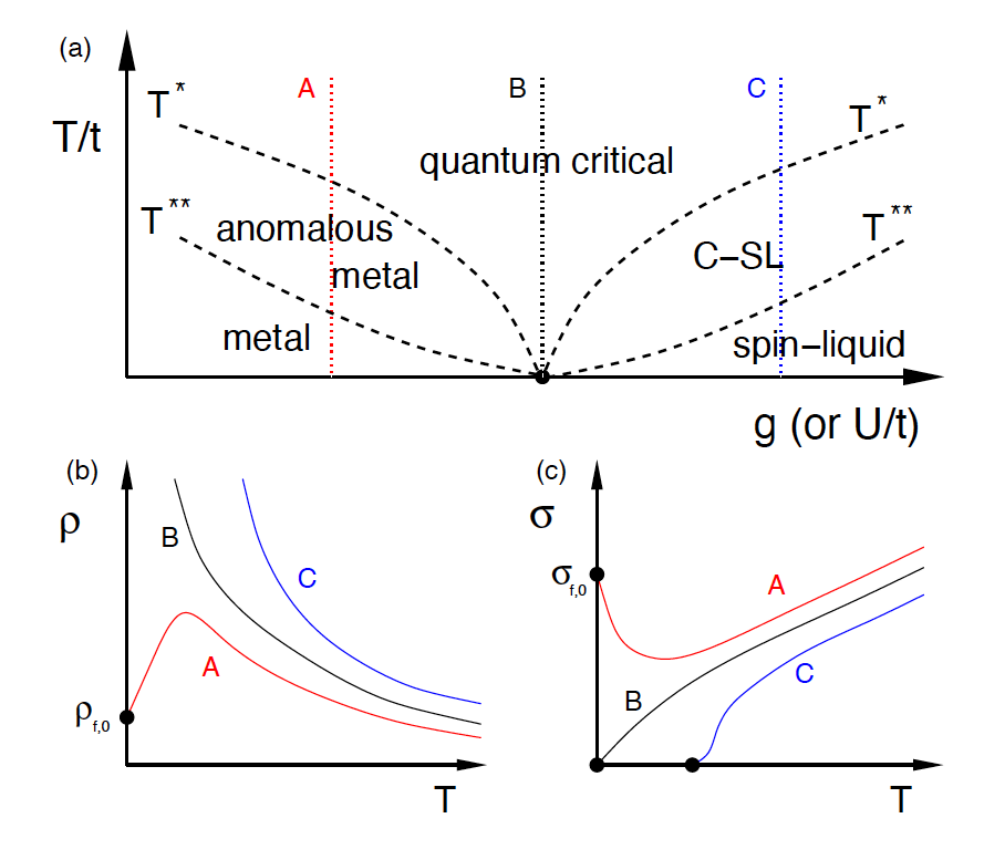
Figure 7. Predictions of the spinon theory (reprinted with permission from Ref. [59] Copyright 2009 American Physical Society). ( a ) The phase diagram features a quantum critical point at T = 0, and two distinct finite- T crossover scales T ∗ (above which the system is quantum critical) and T ∗∗ (below which the system is either a metal or a gapless spin liquid). ( b ) and ( c ) Resistivity and conductivity along the lines A, B and C in the phase diagram in ( a ). Critical resistivity is predicted to diverge as ρ c ( T ) ∼ 1/ t in d = 3, leading to resistivity maxima on the metallic side (coductivity minima). In contrast, the same theory predicts finite critical resistivity ρ c ( T ) ∼ ρ ∗ in d = 2 [53], hence monotonic behavior on both sides of the transition and no resistivity